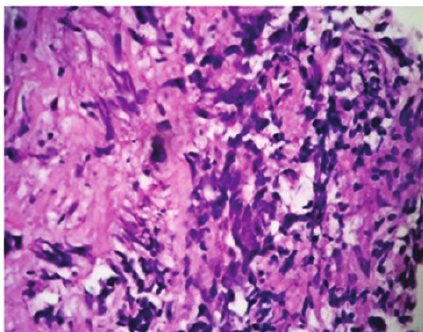
Figure 2: Photomicrograph of biopsy taken from scapular swelling showing ovoid shaped dark cells can be noticed which gives sarcomatous picture.